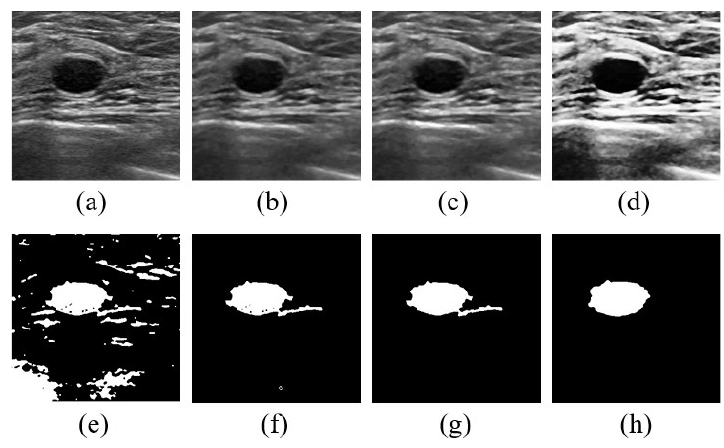
Figure 5. Contour detections for the sample tested for BI-RADS 2 category with Model B: ( a ) original; ( b ) SRAD; ( c ) image normalization; ( d ) image enhancement; ( e ) k-means clustering; ( f ) result after removing regions with small areas or regions touched with image border; ( g ) result image after region ranking; ( h ) result image after region